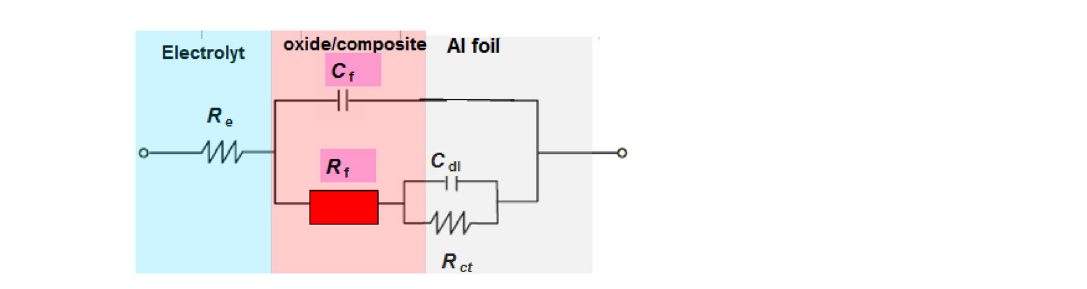
Figure 6. Equivalent circuit fitted for EIS